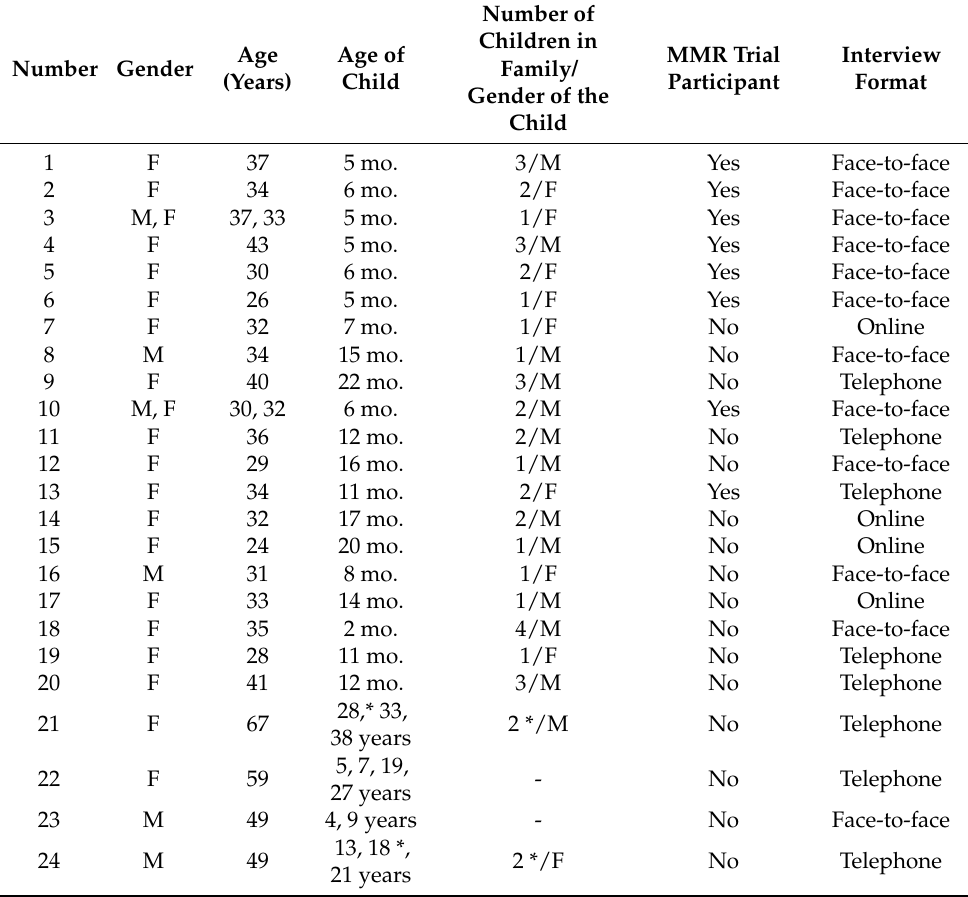
Table 1. Characteristics of participating parents and their